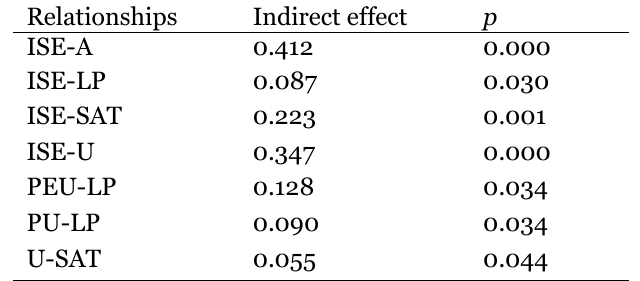
Table 5 Indirect Effects Between